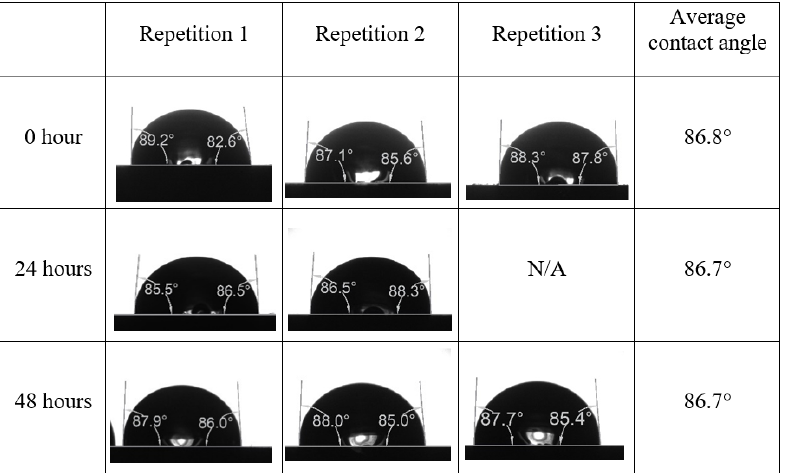
Figure A18. Dynamic Contact Angle Measurement Results for 25% Na 2 SO 4 + 75% CaCl 2 (3500 ppm).